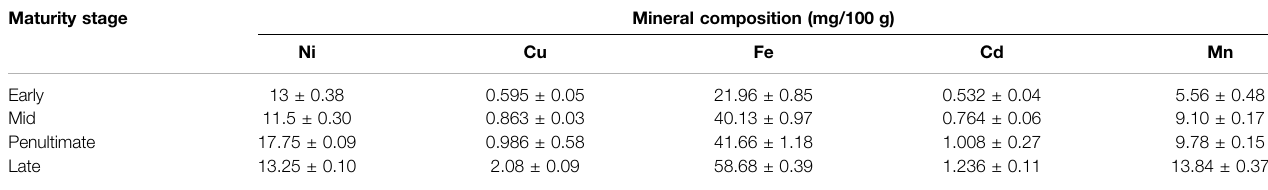
TABLE 6 | Mineral composition (mg/100 g) of M. oleifera leaves at different maturity stages. Maturity